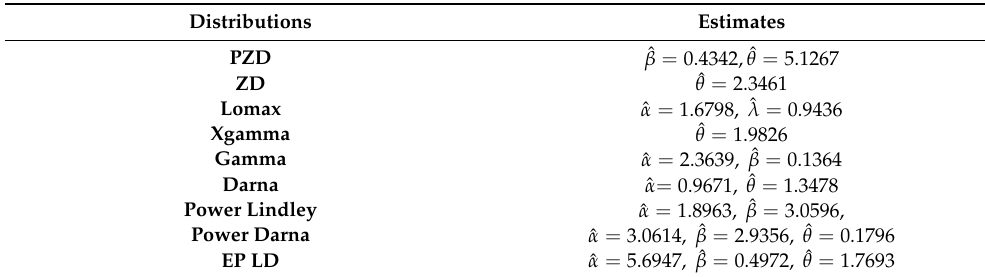
Table 8. ML parameter estimates for the alternative distributions based on cancer patients’